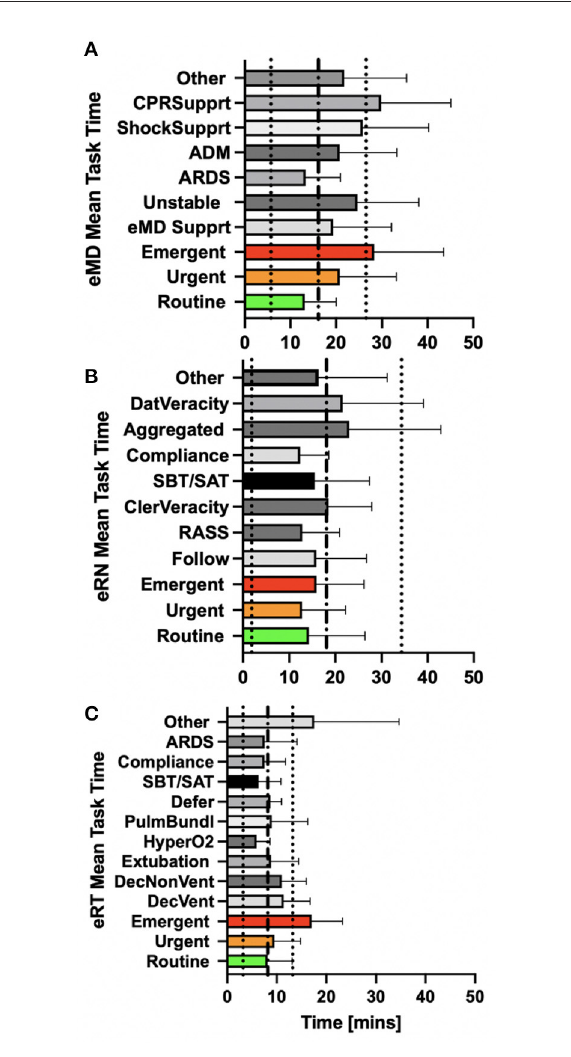
FIGURE2 eMDs spent more time on tasks requiring CPR support followed by tasks that were deemed emergent (A) . eRNs spent the most time on aggregated patient tasks (B) . eRTs spent the most time on tasks described as other (C)